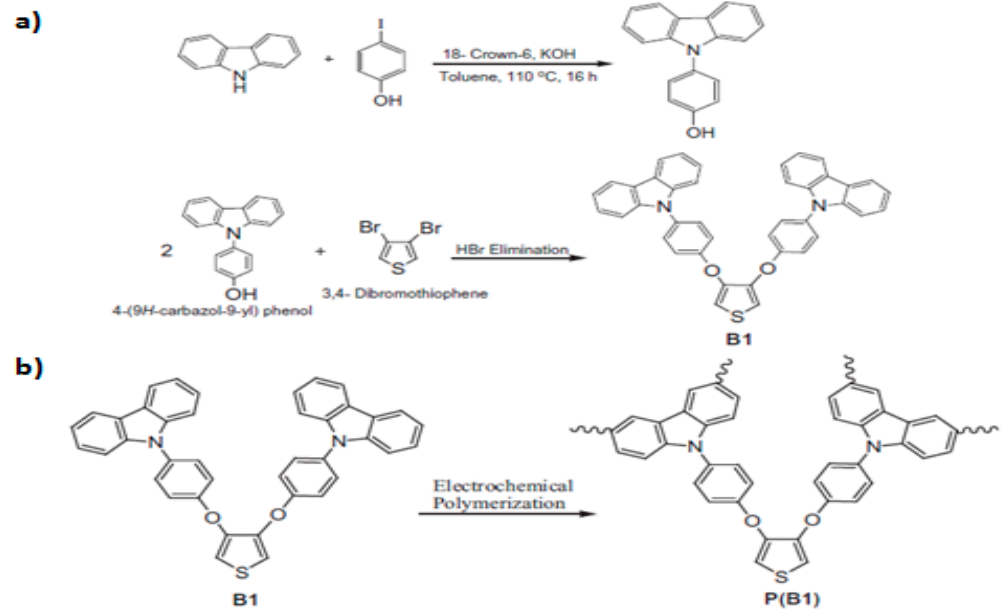
Figure 12. The performed polymer synthesis: ( a ) Synthesis of bis-4-(9H-carbazol-9-yl) phenyl-3,4-diyloxy thiophene (B1). ( b ) Electrochemical synthesis of P(B1). Reproduced with permission from [142]. Copyright (2015) Elsevier.